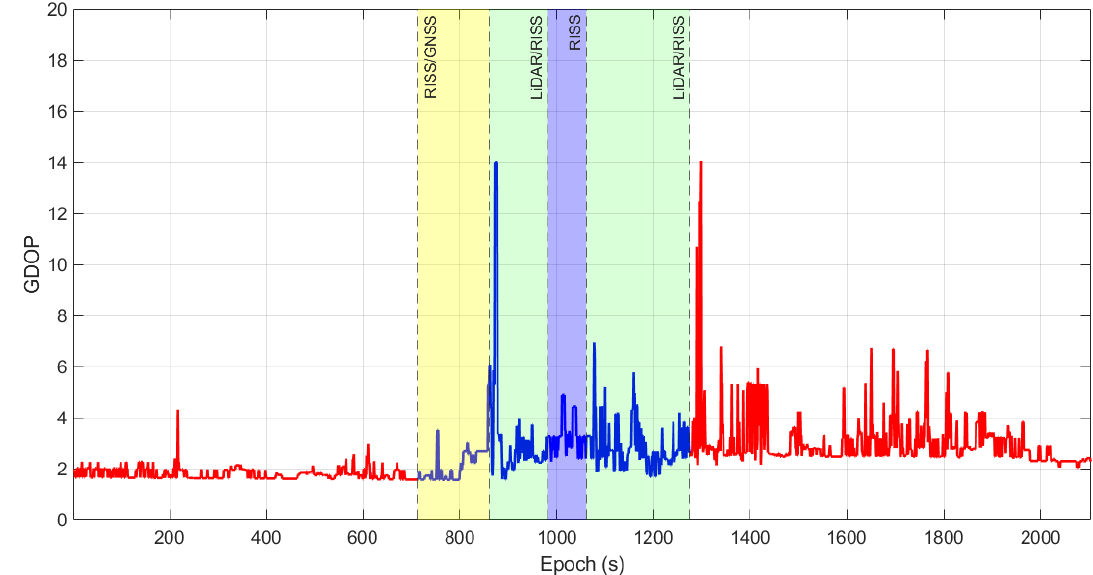
Figure 22. GDOP Values Before, During, and After the Scenario Highlighting the Switching Between the Systems.